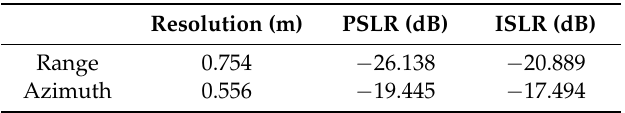
Table 6. The performance of compression after model error